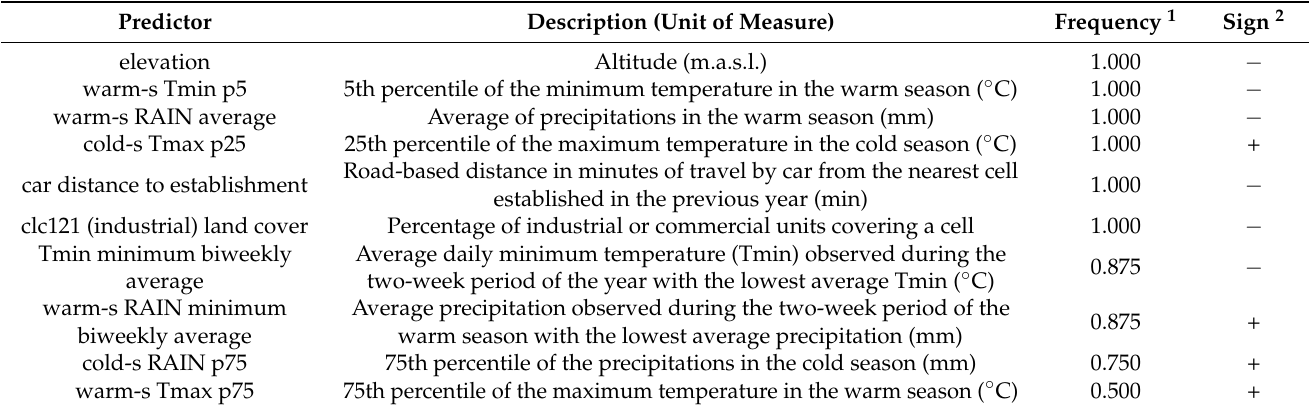
Table 2. Informative predictors selected by lasso